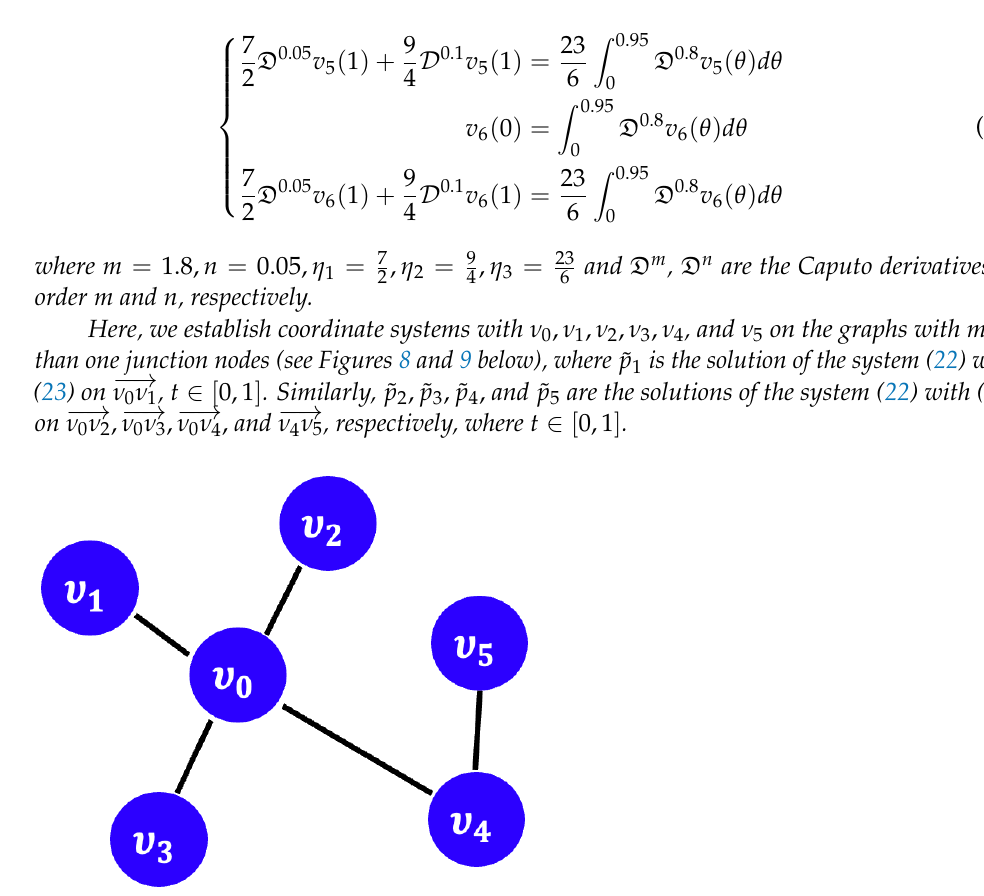
Figure 8. A sketch of a graph.